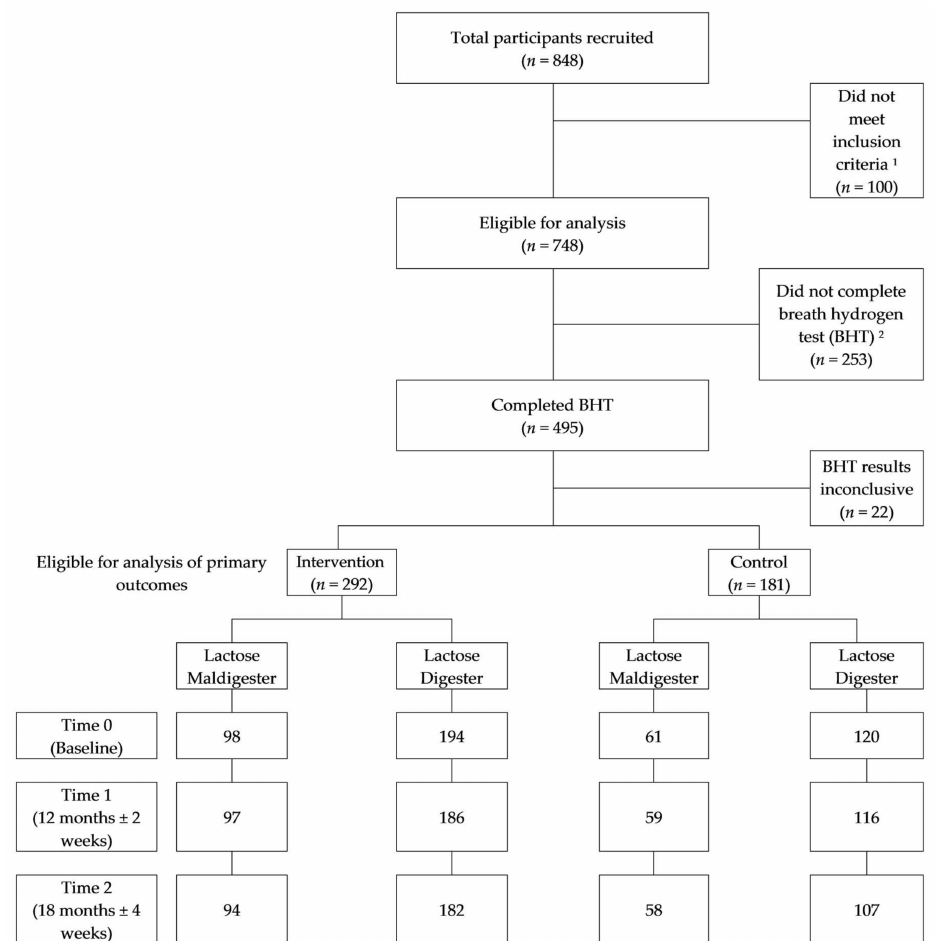
Figure 1. Consort diagram of participants included for analysis in the Adequate Calcium Today project; 1 Inclusion criteria of ethnic group not met; 2 Breath hydrogen test (BHT) was needed for classification of lactose maldigestion